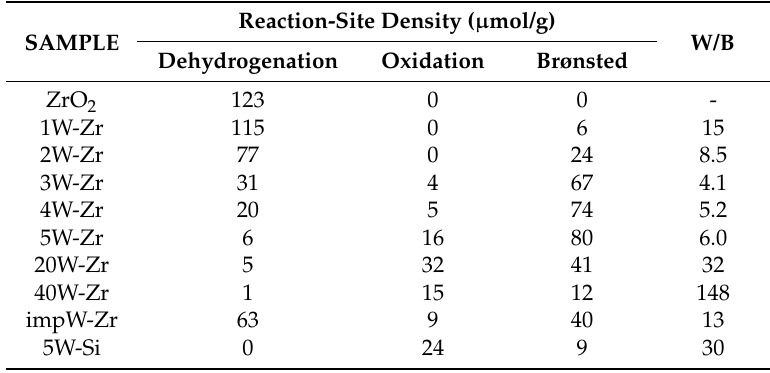
Table 2. Reaction site densities determined from the desorption features of 2-propanamine TPD, determined as described in the text. W/B = number of W atoms per Brønsted